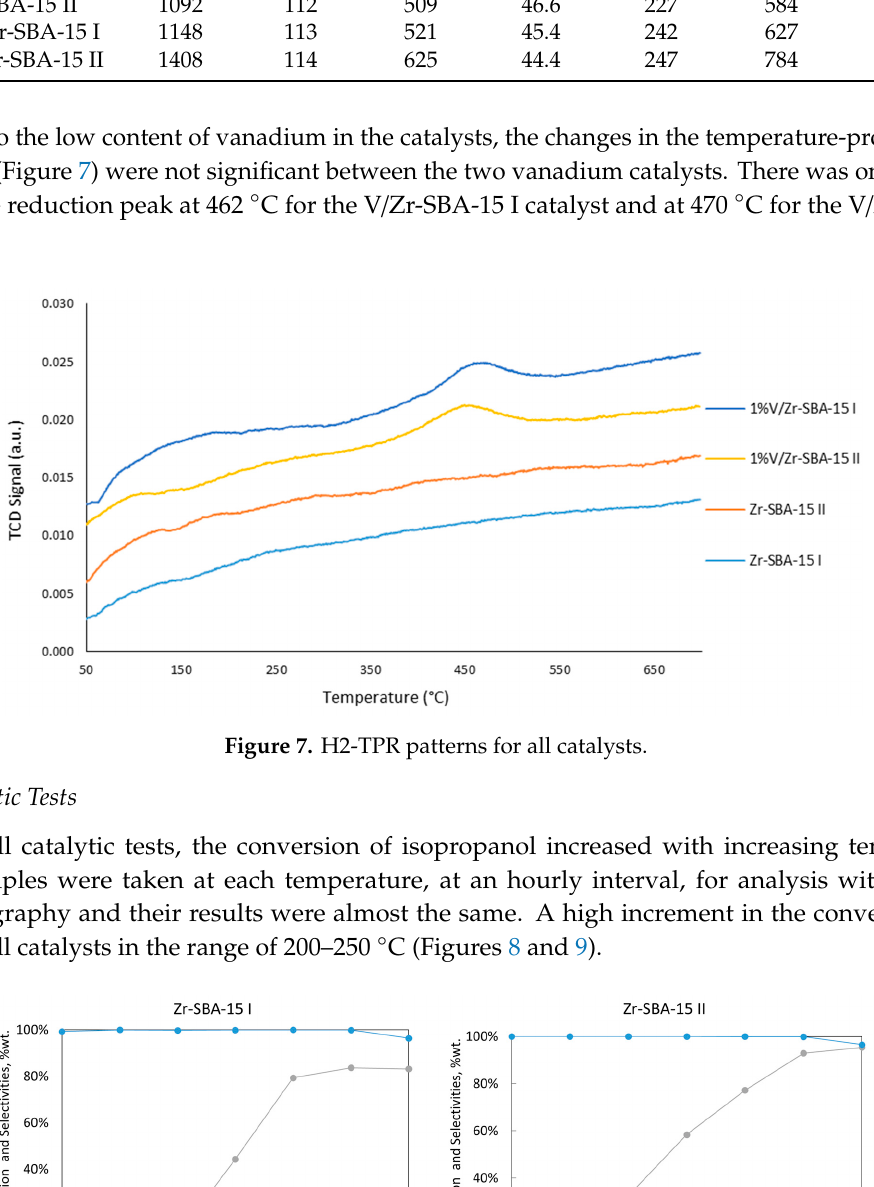
Figure 8. Isopropanol conversion and selectivity to propene and acetone for the Zr ‐ SBA ‐ 15 I ( a ) and Zr ‐ SBA ‐ 15 II ( b ) catalysts.